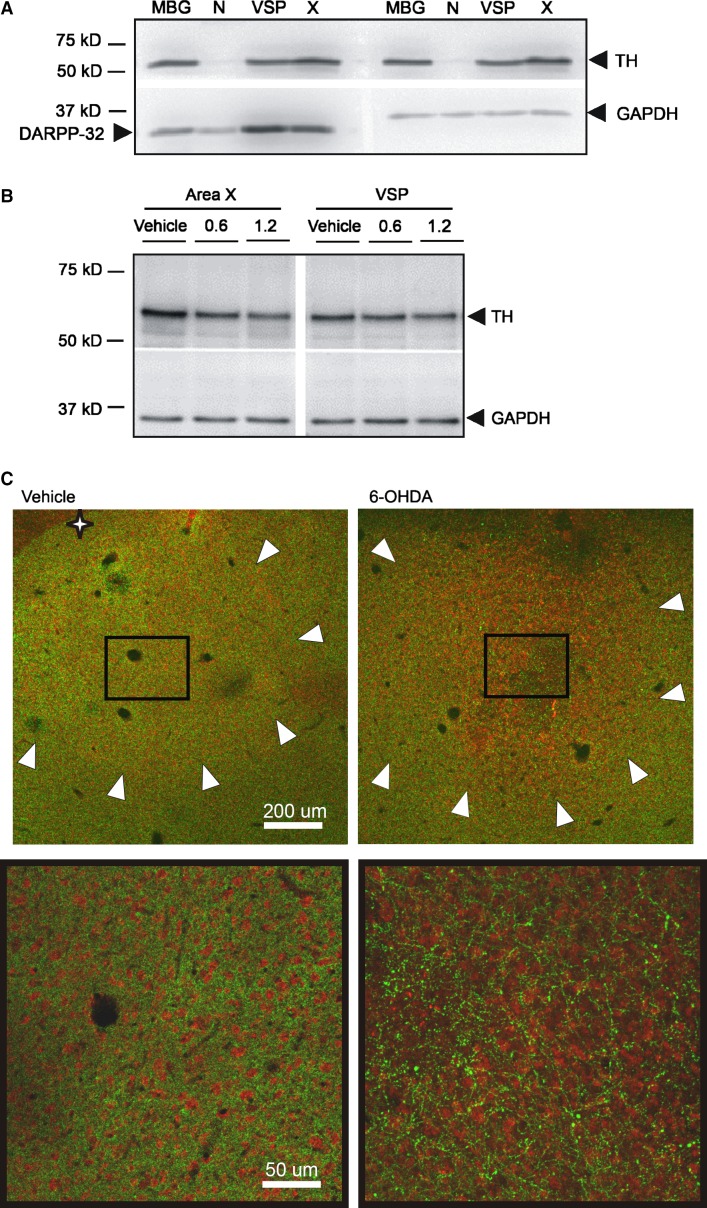
Tissue measurements of DA biomarkers. (A) Immunoblot (40 μg protein/lane) from Area X, VSP, nidopallium (N), and mouse basal ganglia (MBG) lysates. Signals are at the expected molecular weights (kD) and show the expected reduction in TH signal within nidopallium. (B) Immunoblot (15 μg protein/lane) from Area X and VSP lysates. Compared to vehicle (lane 1: 2.82, normalized protein levels), TH signal appeared reduced in Area X following both 0.6 μg (lane 2: 1.75) and 1.2 μg (lane 3: 1.03) doses of 6-OHDA, with more substantial reduction at the higher dose. TH signals in VSP exhibited less change as expected given the targeted injection to Area X (lanes 4–6; vehicle: 1.31; 0.6 μg: 1.06, 1.2 μg: 0.93). (C) Decreased TH immunostaining in Area X following 6-OHDA injection. Photomicrographs show double-labeling for TH positive fibers in green and NeuN, a neuronal marker, in red. The star indicates the striato-pallidal border – beyond this border, the nidopallium lacks the density of TH fibers. Arrowheads outline Area X (top); rectangle highlights inset shown below at higher magnification. There are fewer TH fibers (green) in the 6-OHDA injected Area X compared to vehicle-injected but the density of NeuN staining (red) indicates that Area X neurons are preserved.